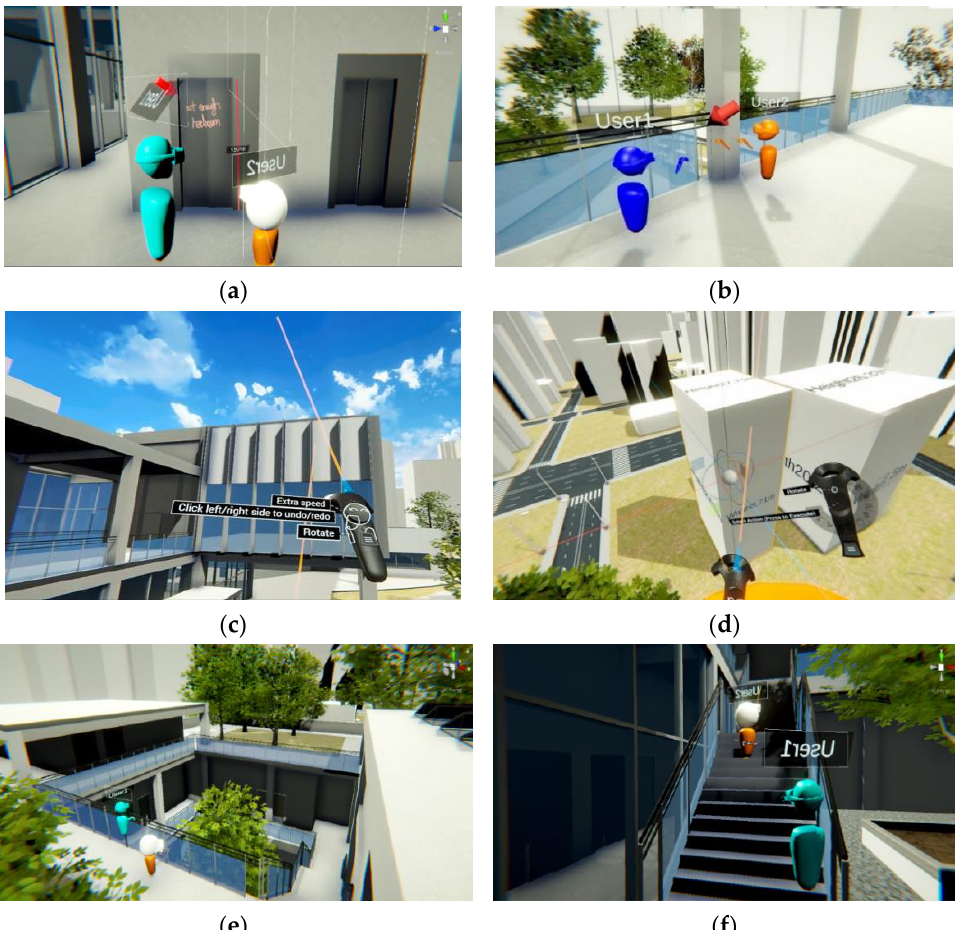
Figure 5. Multiple scenarios for system testing by a pair of participants: ( a ) conflict resolution, ( b ) design detailing, ( c ) design overview, ( d ) design creativity, ( e ) walking along the corridor, and ( f ) walking along the staircase.